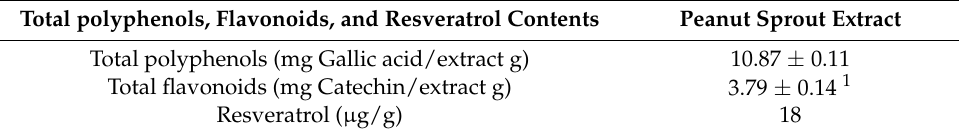
Table 1. Total polyphenol, flavonoid, and resveratrol contents of peanut sprout